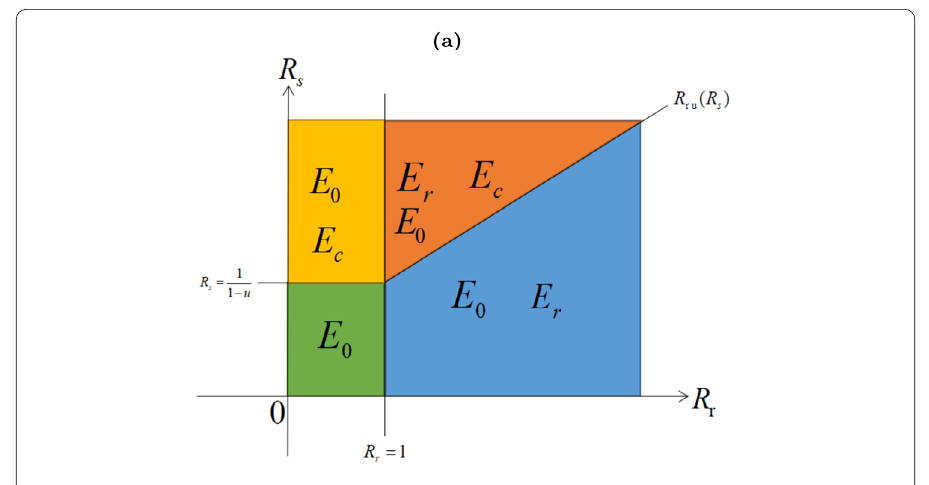
Figure 1 The existence of equilibria of model (2)